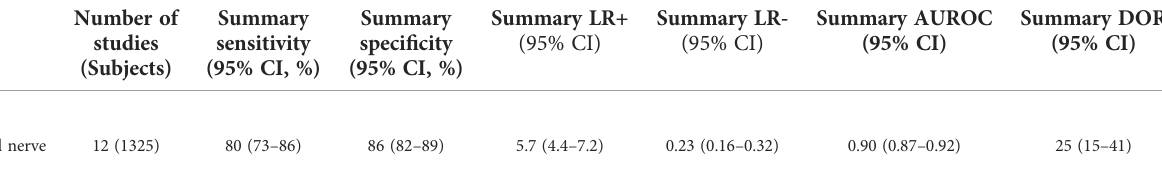
TABLE 4 Meta-analysis results of tibial nerve stiffness measurement by SSI for prediction of DPN.